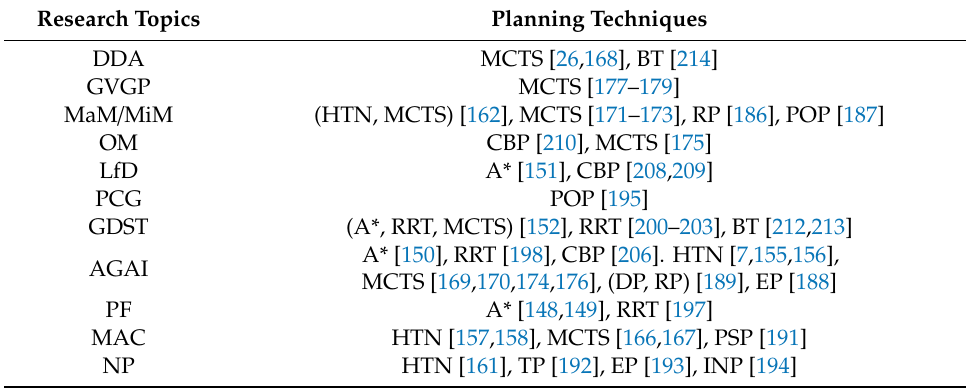
Table 4. Table presenting some of the most common game AI research topics together with examples of proposed implementations using the planning techniques discussed. The acronyms used in the table stand for respectively: Dynamic Di ffi culty Adjustment (DDA), General Video Game Playing (GVGP), macromanagement (MaM), micromanagement (MiM), Opponent Modeling (OM),